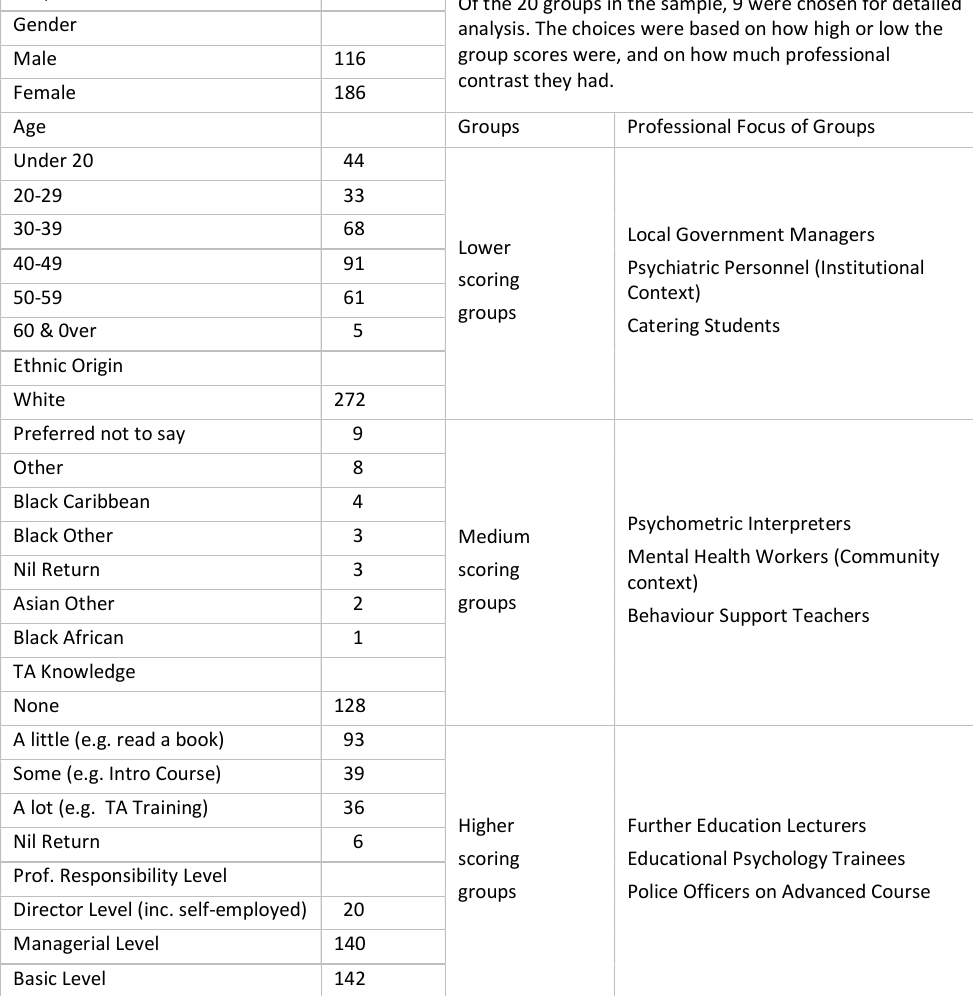
Table 3: Demographic Details of Pilot Sample & Range of Groups Analysed in Detail Respondents N=302 Of the 20 groups in the sample, 9 were chosen for detailed analysis. The choices were based on how high or low the group scores were, and on how much professional contrast they